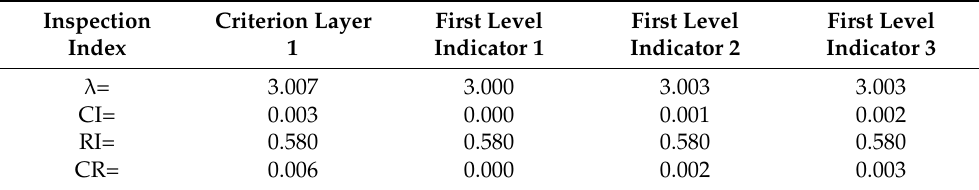
Table 2. Consistency